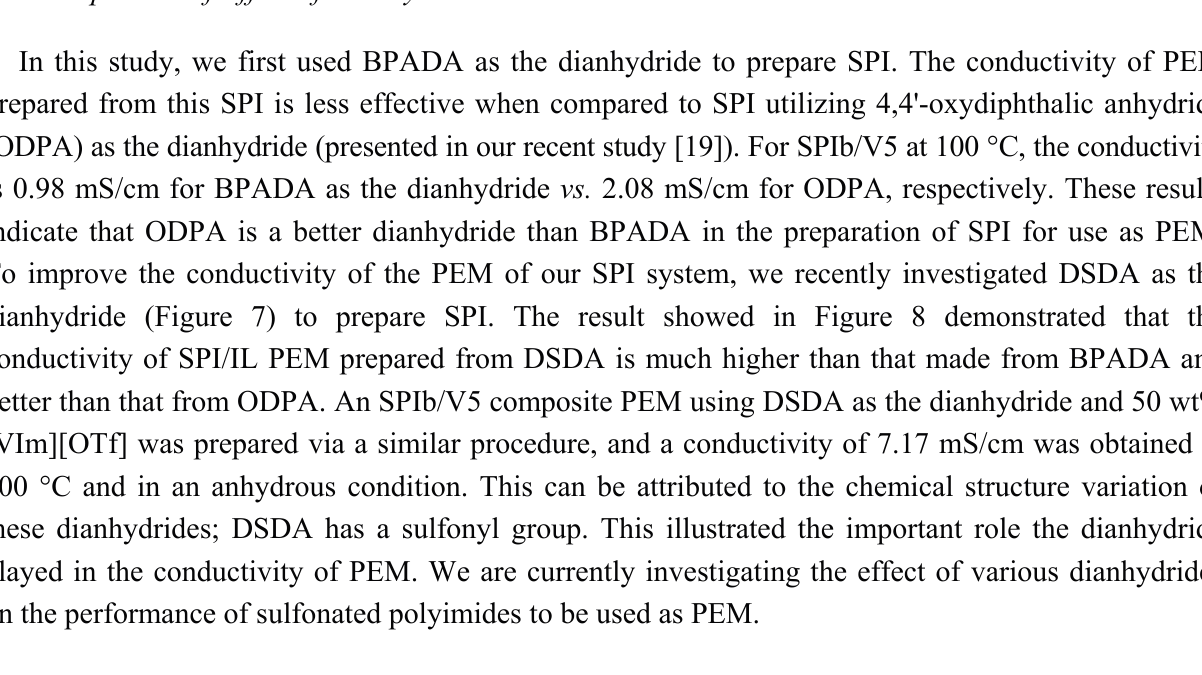
Figure 7. Chemical structure of dianhydrides. ODPA, 4,4'-oxydiphthalic anhydride; DSDA, 3,3',4,4'-diphenyl sulfone tetracarboxylic